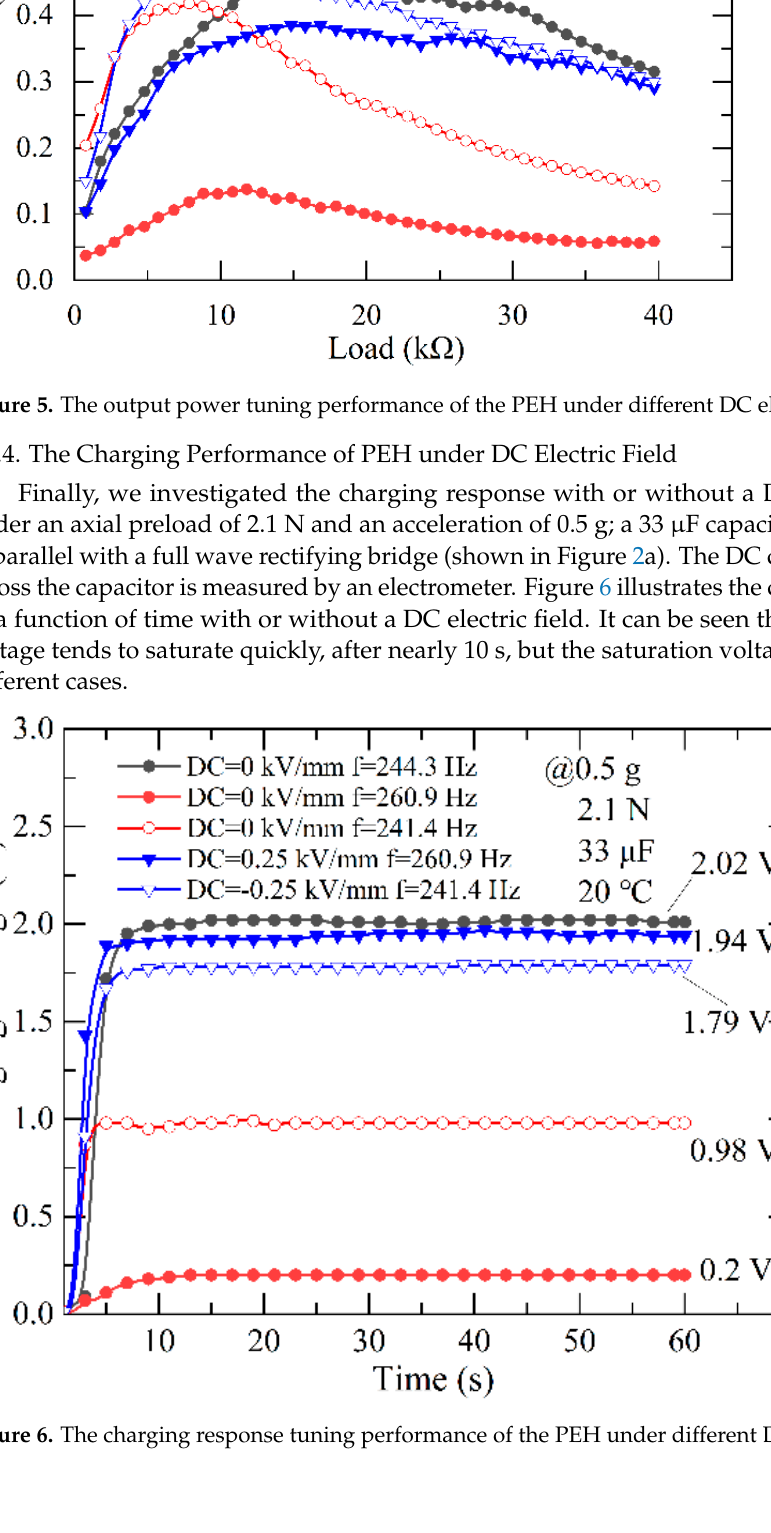
Figure 6. The charging response tuning performance of the PEH under different DC electric fields.